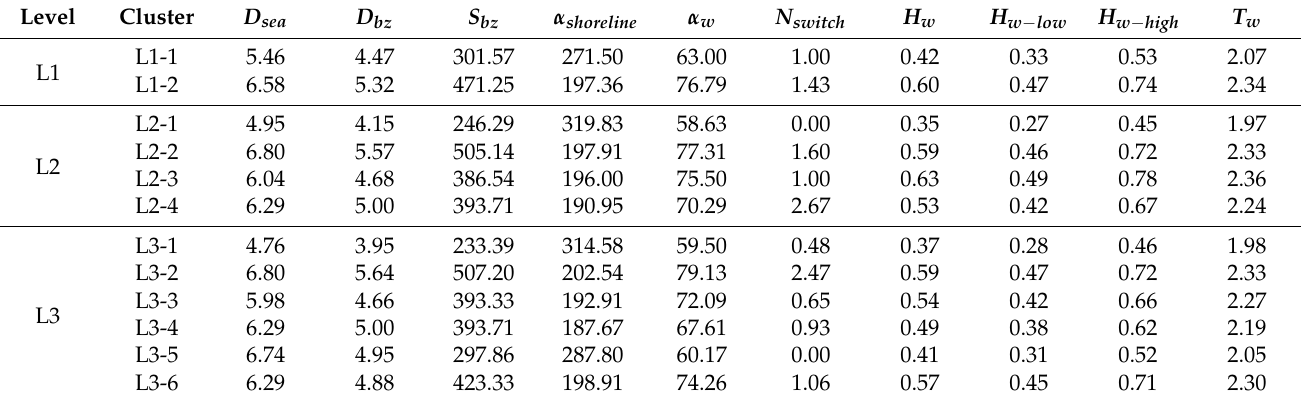
Table 2. Mean values of the environmental and bar zone variables for the nearshore bar behaviour regions